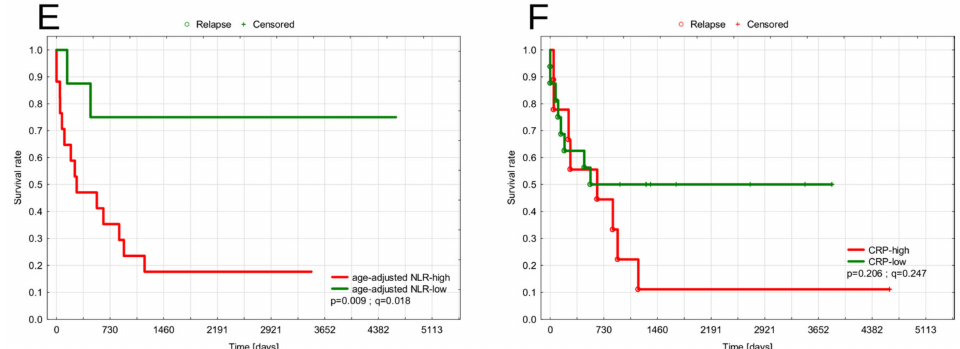
Figure 9. Kaplan–Meier curves showing the probability of relapse-free survival grouped by SLC2A1 ( A ), HIF-1a ( B ), CA9 ( C ), VEGFA ( D ), NLR ( E ), and CRP ( F ). Abbreviations: SLC2A1—solute carrier family 2 member 1, HIF1A—hypoxia-inducible factor-1 α , CA9—carbonic anhydrase 9, VEGFA—vascular endothelial growth factor A, NLR—neutrophil-to-lymphocyte ratio, CRP—C-reactive protein.